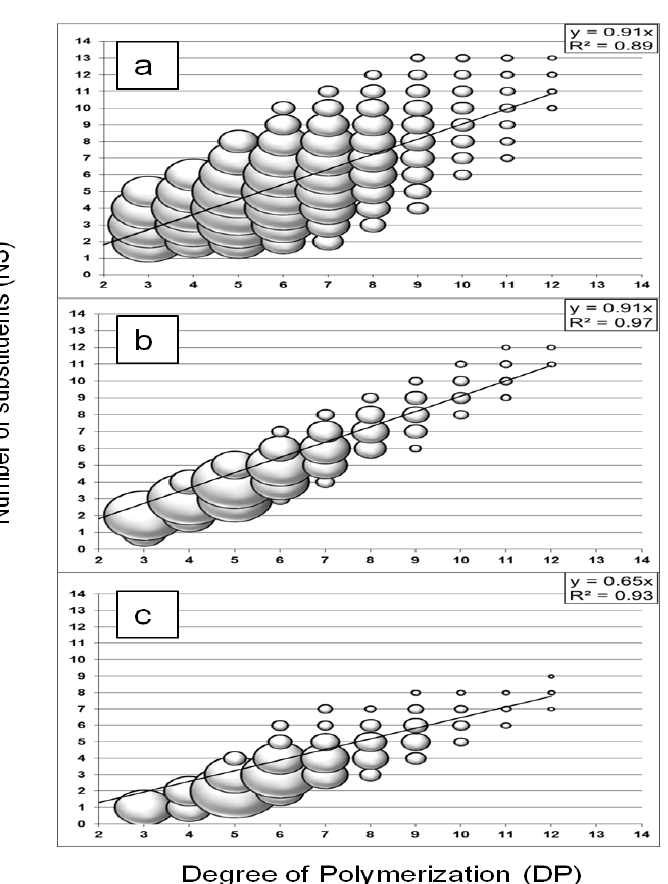
Figure 1. Comparison of carboxymethyl cellulose (CMC) hydrolysis profiles obtained with ( a ) trifluoroacetic acid (TFA) 2M, ( b ) a commercial cellulase from Trichoderma reesei , ( c ) termite hindgut homogenates ( Reticulitermes santonensis ). The oligosaccharides produced were analyzed by MALDI-TOF MS and displayed with markers according to their degree of polymerization (DP) and total number of substituents (NS), identified from m/z values. The relative intensity of each compound was represented by the spherical volume of the